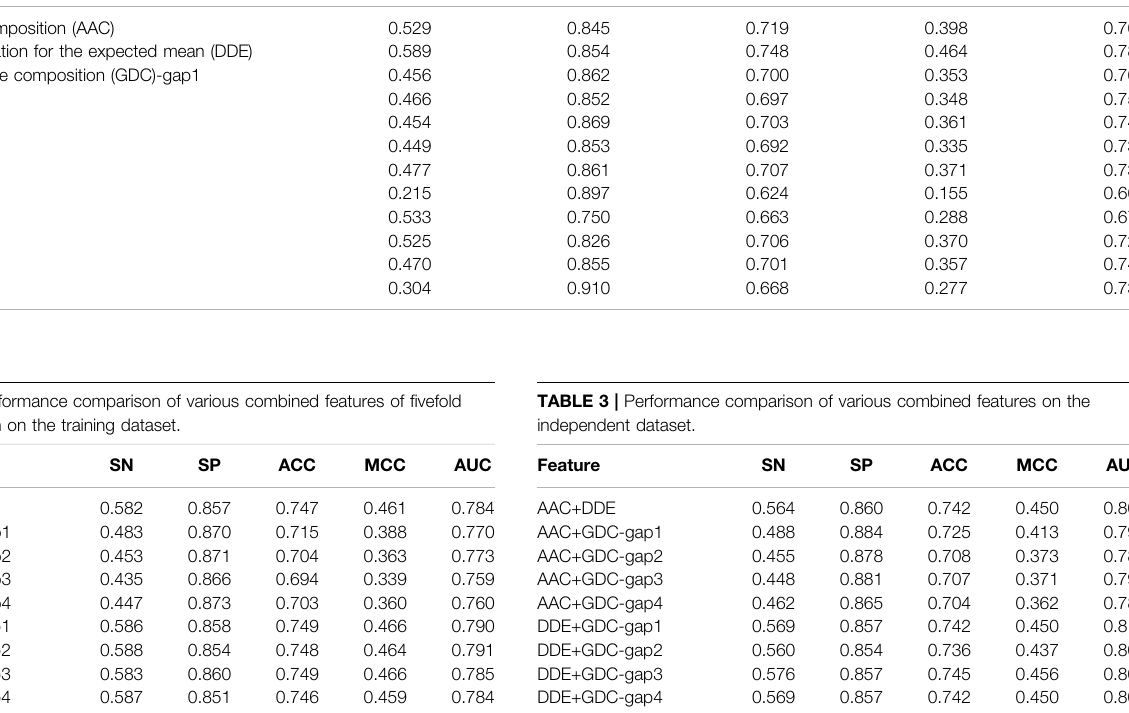
TABLE 1 | Performance comparison of various single features. Feature SN SP